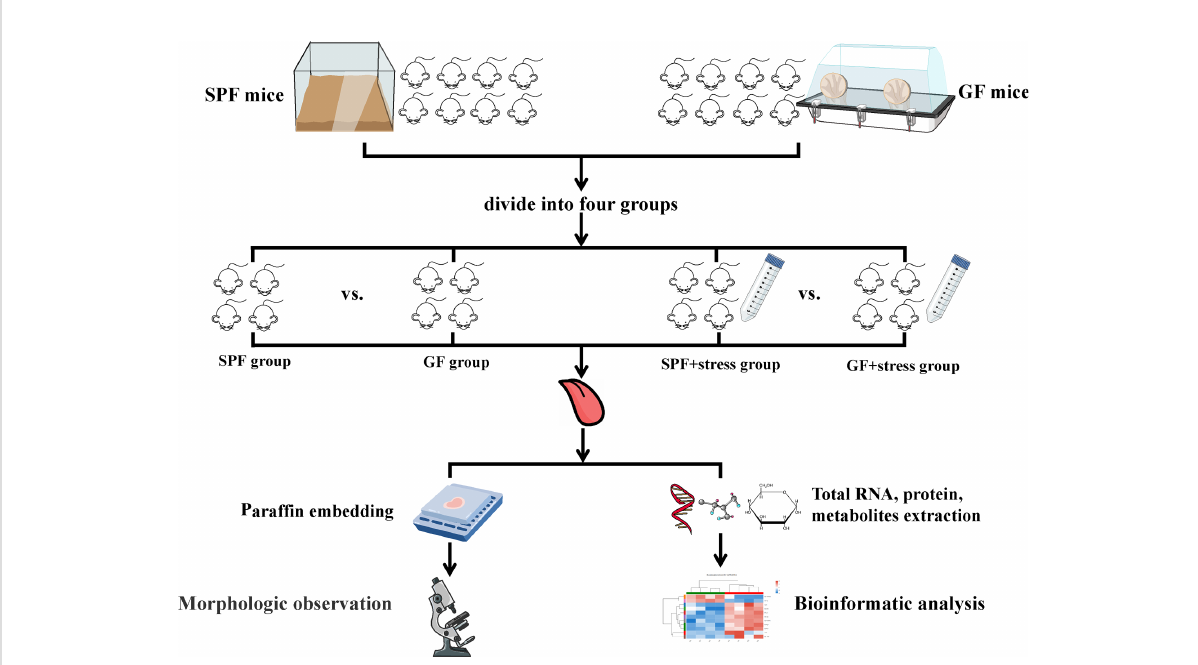
FIGURE 1 Flowchart of this study. (n=4/SPF group; n=4/GF group; n=4/SPF + chronic stress group; n=4/GF + chronic stress group). SPF mice, speci fi c pathogen-free mice; GF mice, germ-free